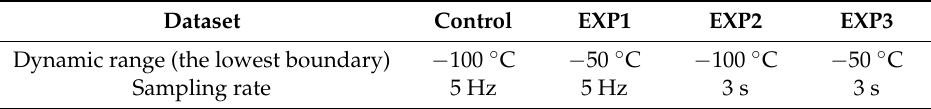
Table 3. The four experimental datasets are used to analyze the effects of the disparate specifications of IRT to the cloud detection algorithm. Each dataset has a different dynamic range (the lowest boundary) and/or sampling rate. The original Tb IRT are used for the “Control”, while the other experimental datasets having different characteristics are prepared using the original data. Note that EXP3 has the same dynamic range and sampling rate as those of the previous study [9], but with slightly better temperature